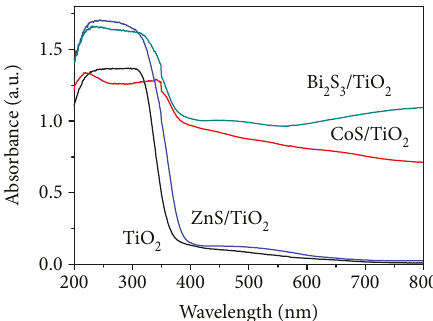
Figure 2: UV – vis DRS of the samples.